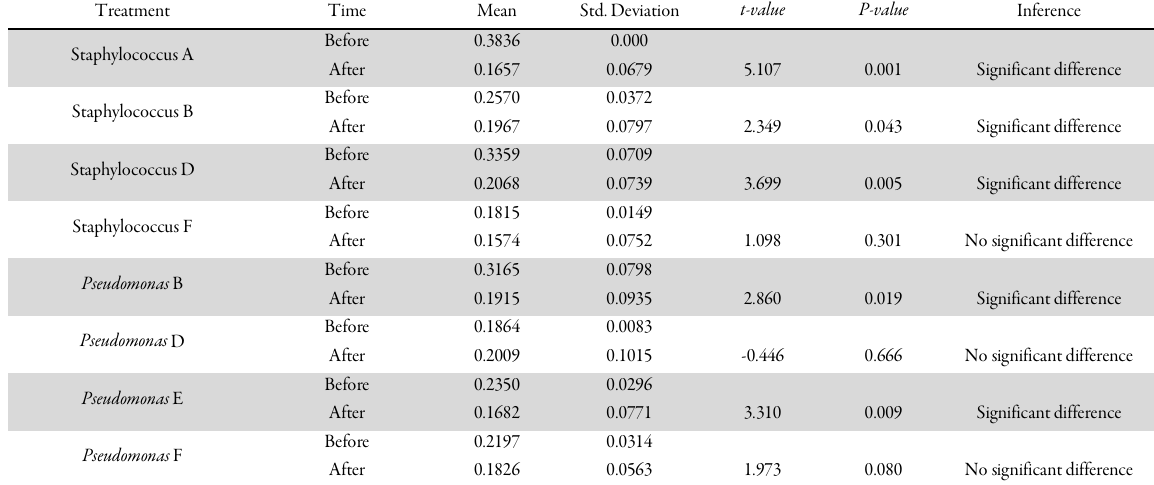
Table 5. Comparison of growth rate of Staphylococcus and Pseudomonas spp. isolated from different soil samples before and after curing